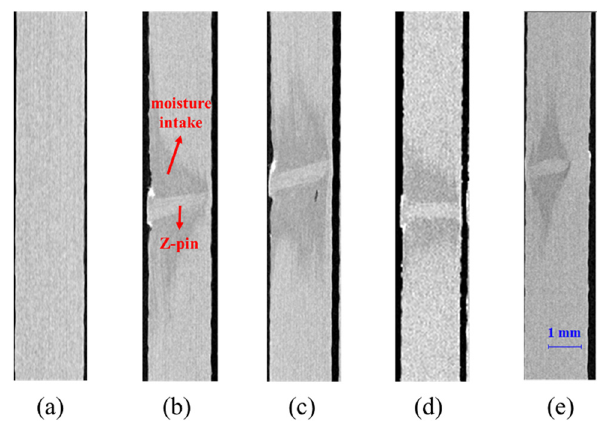
Figure 3: Microscopic morphology through the third direction of ( a ) composite after moisture for 7 days, ( b and c ) Z - pinned composite after moisture for 7 days, and ( d and e ) Z - pinned composite after moisture coupled with fl exural load for 7 days.